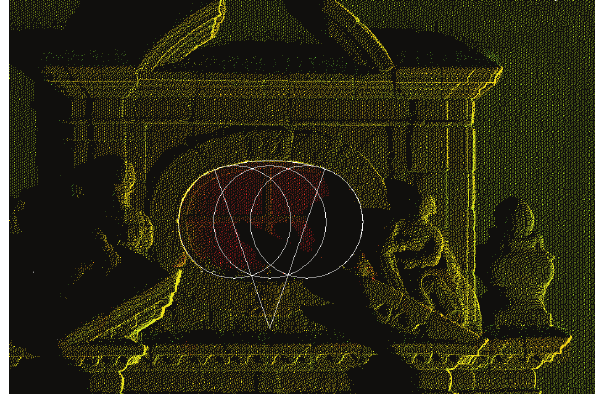
Figure 16. From the cloud point to the geometric model of Saint